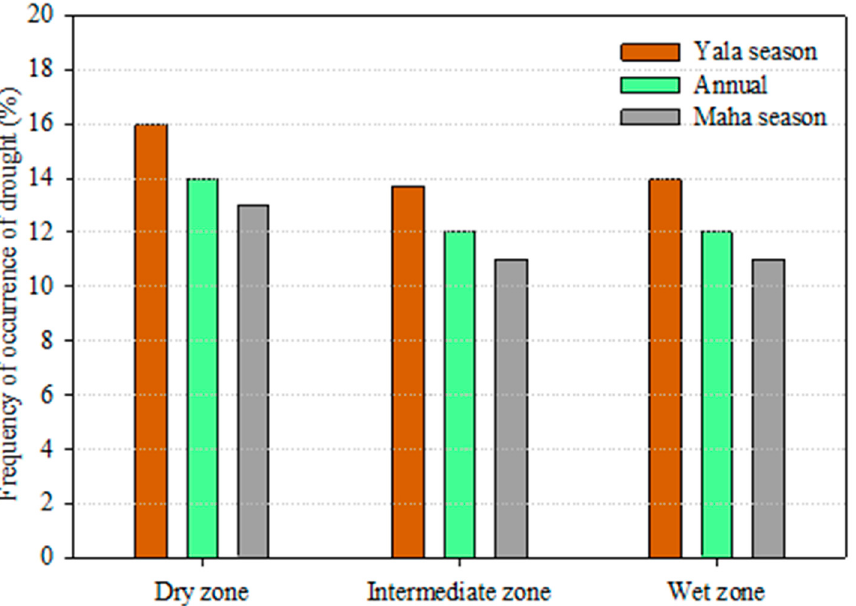
Figure 8. Frequency of occurrence of moderate to extreme drought conditions in dry, intermediate, and wet zones Yala and Maha seasons and annual time scale.